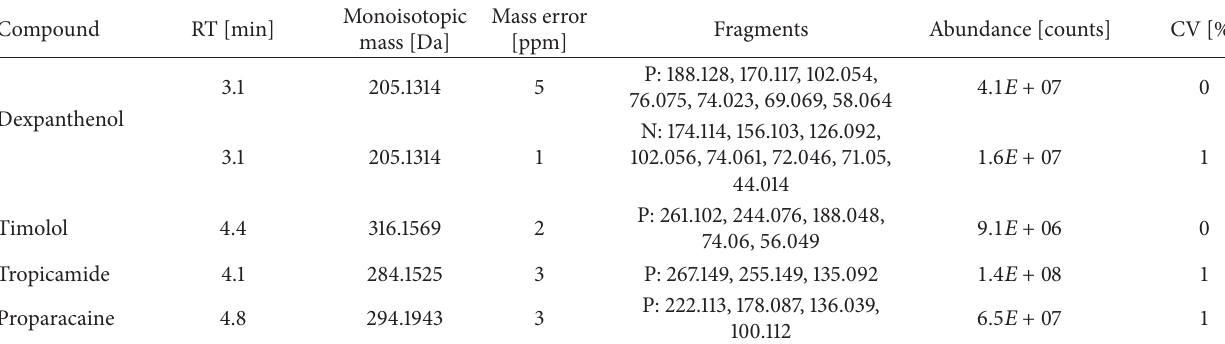
Table 4: The list of drugs identified in aqueous